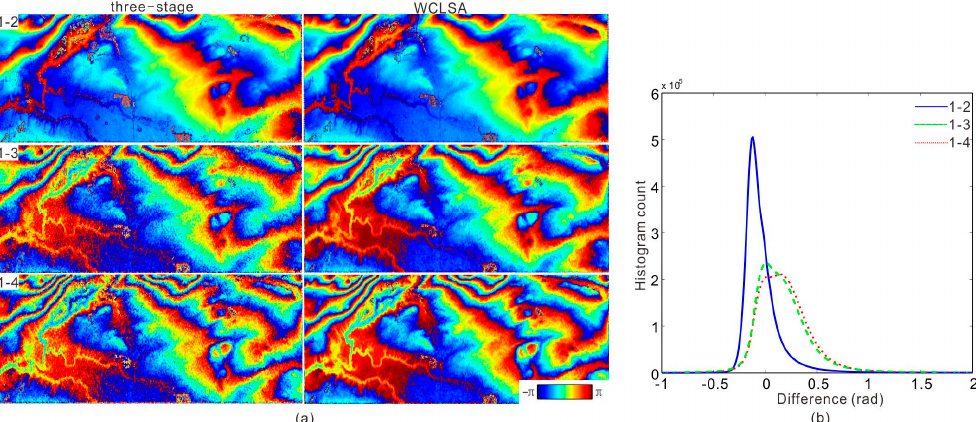
Figure 10. ( a ) Maps of forest ground interferometric phase estimated by three-stage (linear fitting) and WCLSA respectively for baseline 1–2, 1–3 and 1–4; and ( b ) Histograms of differences between three-stage ground phases and WCLSA